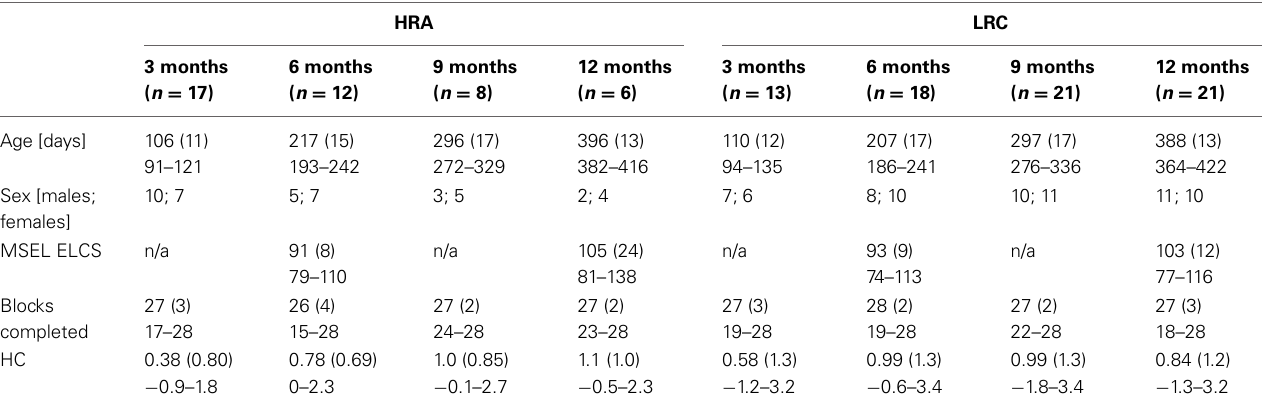
Table 1 | Participant information.